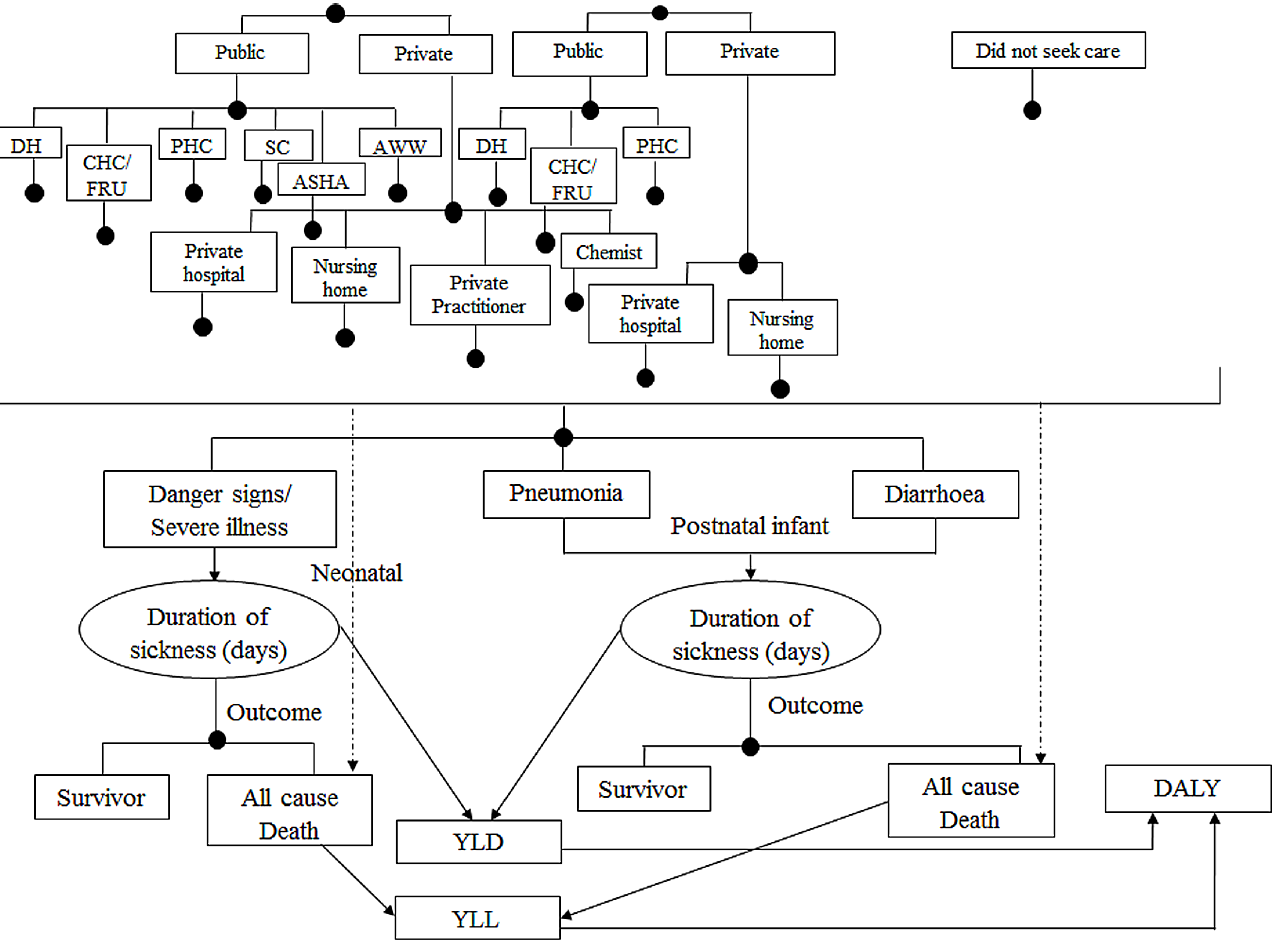
Fig 2. Outcome Model for Cost-effectiveness of IMNCI in Haryana, India. Note : In continuation to the model 1, outcome model describes the probable scenarios after a neonatal or post-neonatal infant had been treated or not (irrespective of type of health facility). YLD = Years of life lived with disability, YLL = Years of life lost due to premature mortality, DALY = Disability adjusted life